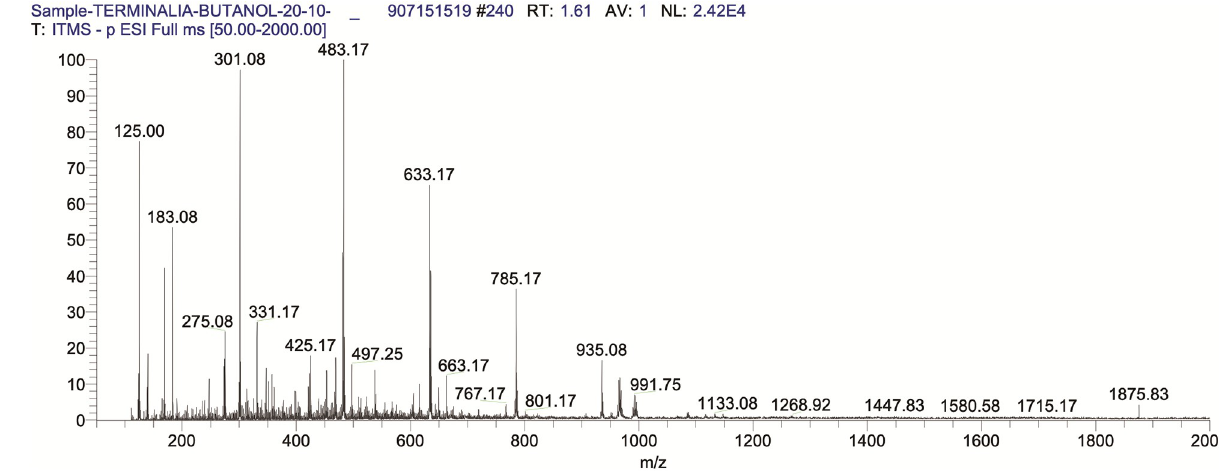
Fig 2. TIC of BUAE in negative ion scan